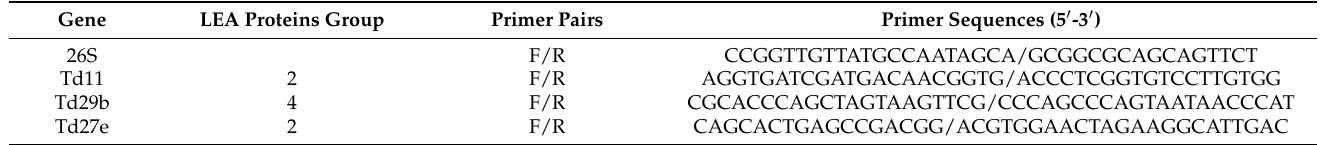
Table 3. The sequences of primers used in the